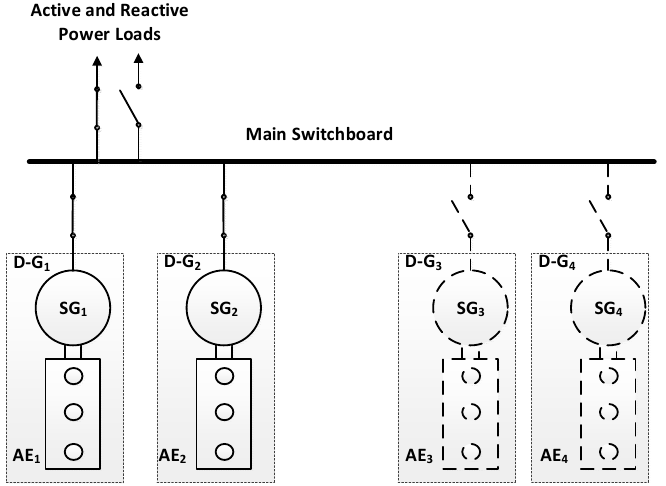
Figure 1. Simplified diagram of a ship power system.